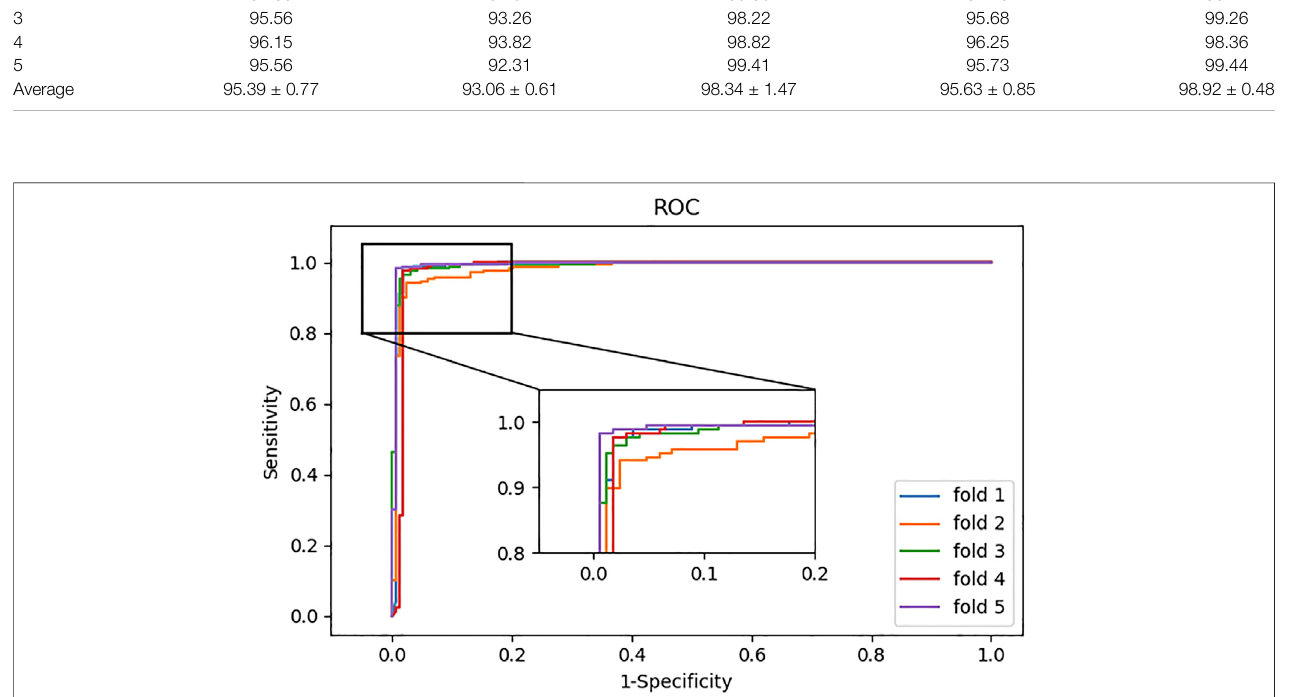
FIGURE 4 | ROC curves of fi vefold CV obtained by SAAED on the CircR2Disease Dataset.